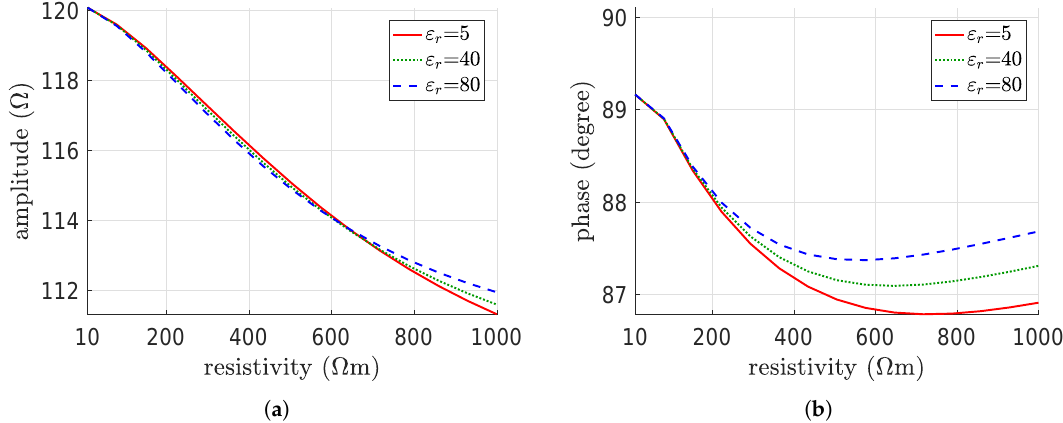
Figure 19. Equivalent impedance of the embedded coil ( Mod3 ) at 85 kHz for a concrete resistivity from 10 Ω m to 1000 Ω m, parametrized for ε r equal to 5, 40, and 80. Amplitude ( a ); phase ( b ).